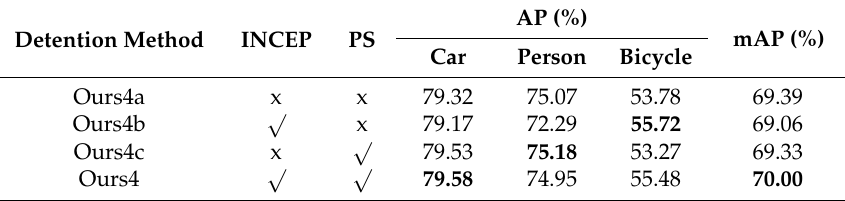
Table 3. The results of comparative experiments of different parts in multi ‐ scale pooling. Bold numbers indicate the highest indicator values of all frames. IOU threshold is 0.3. All experiments utilize double ‐ layer RPN pyramid (DR), instance level data augmentation (ILDA), and Online Hard Example Mining (OHEM).